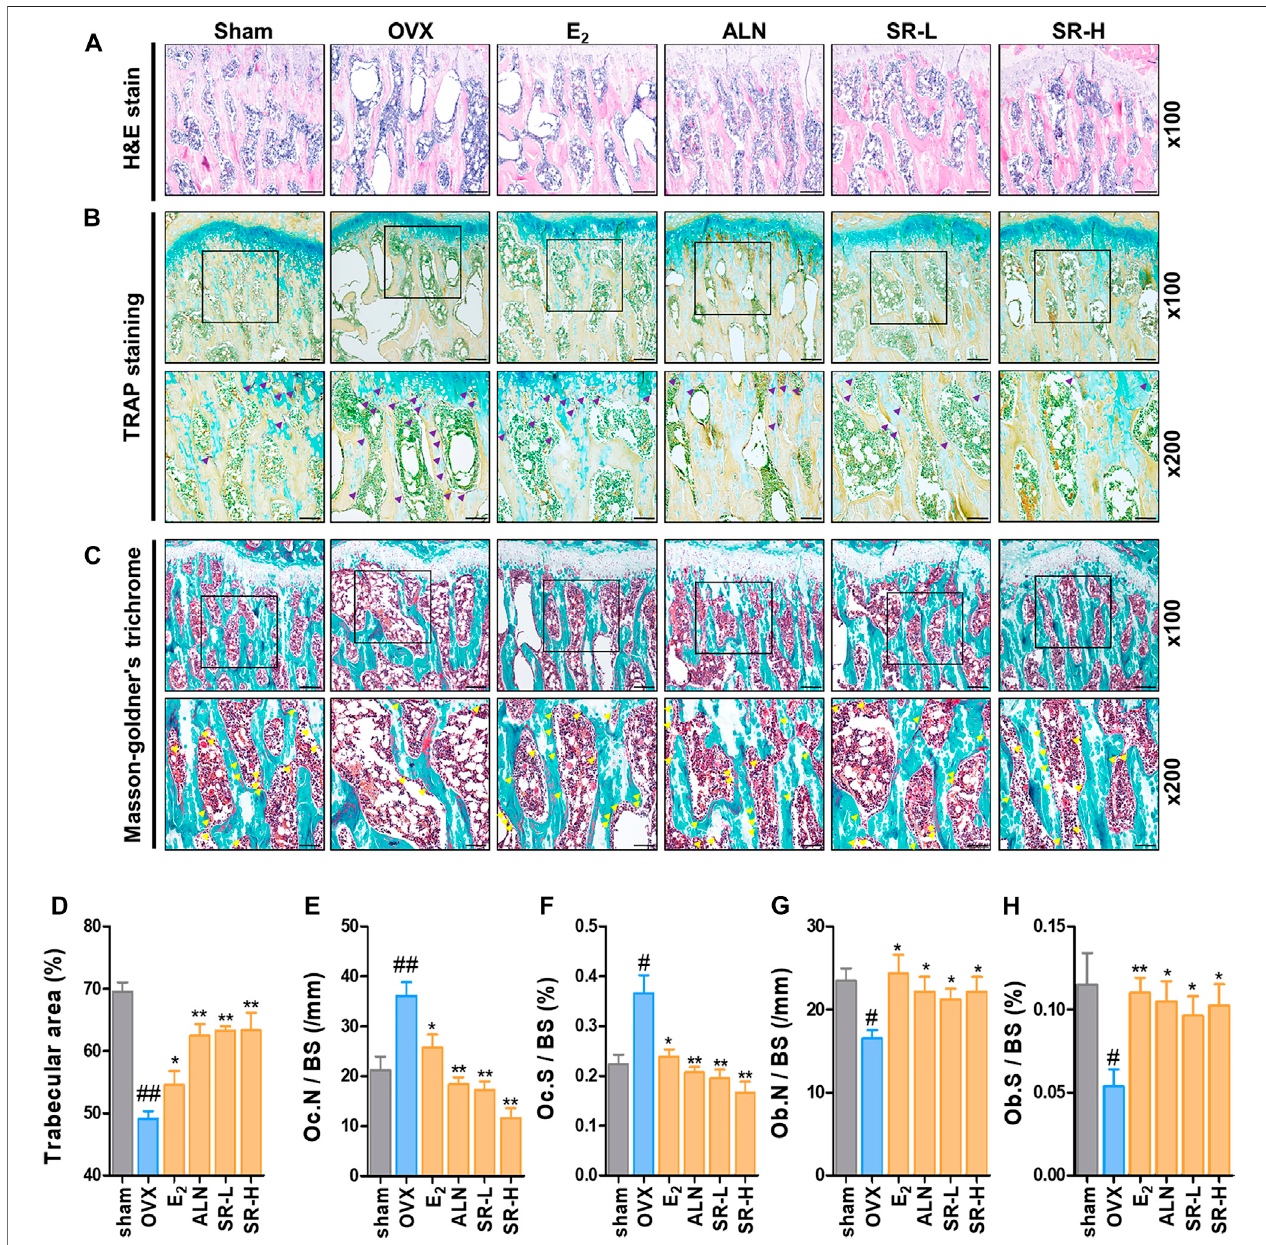
FIGURE 9 | Effect of SR on trabecular area, osteoclasts and osteoblast in the OVX-induced rats. (A) The trabecular area was measured using H&E staining of femur tissue. (B) The number of osteoclasts (purple) in the femoral tissue was veri fi ed through TRAP staining. (C) The number of osteoblasts (yellow) in the femoral tissue was measured through masson-goldner ’ s trichrome staining. (D) Trabecular area, (E) Oc.N /BS (/mm). (F) Oc.S /BS (%). (G) Ob. N/BS and (F) Ob. S/BS were measured using ImageJ version 1.46. The results are presented as the mean ± SEM of each experimental group ( n (cid:2) 8). Statistical analysis was performed using one-way ANOVA followed by Dunnett ’ s post hoc test. ## p < 0.01, # p < 0.05 vs. the normal group (sham-operation group); * p < 0.05, ** p < 0.01 vs. the control group (OVX-induced